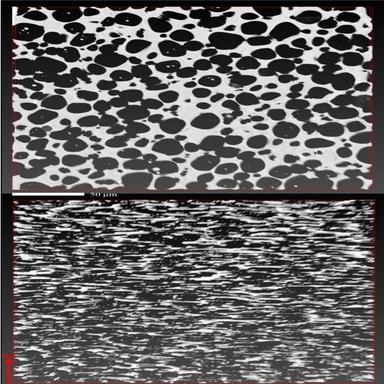
2D planar views of the ductile Ni-Fe-W phase in the AR (top) and the R87 TD-ND (bottom), obtained from 3D reconstructions showing changes in the Ni-Fe-W phase continuity via hot-rolling.